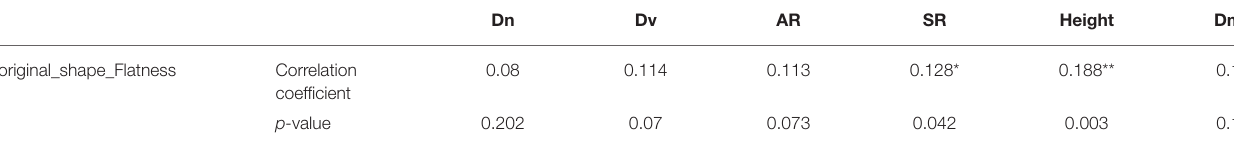
TABLE 4 | Correlation between the advanced morphological feature flatness and traditional features. Dn Dv AR SR Height